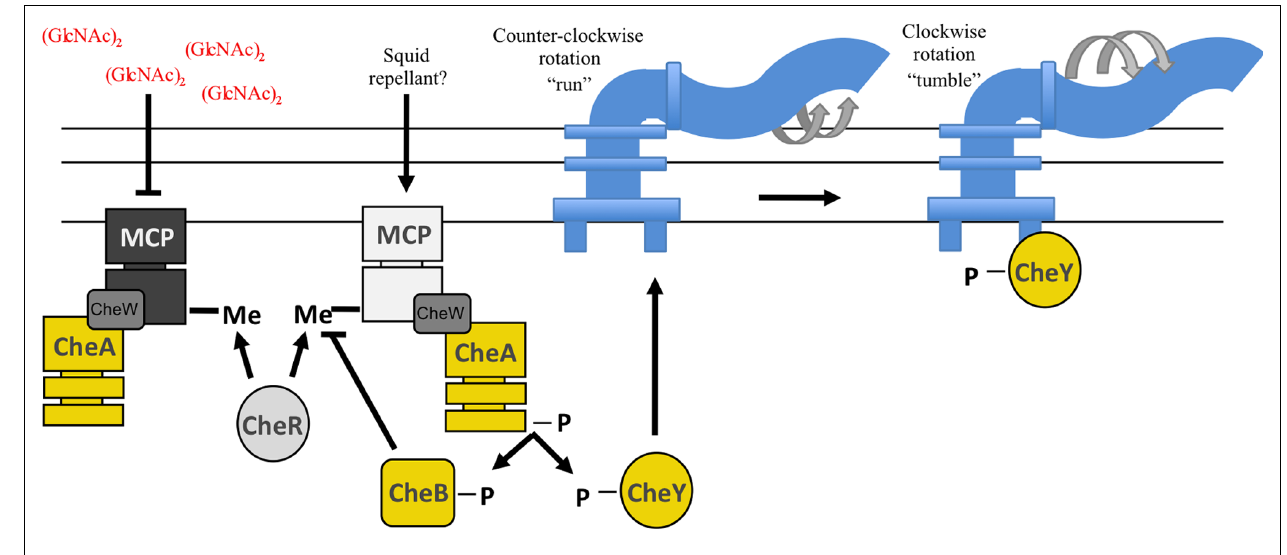
FIGURE 4 | Predicted chemotaxis pathway in V. fischeri . Methyl- accepting chemotaxis proteins (MCPs) recognize specific molecules found in the environment. A MCP is often physically linked to the sensor kinase, CheA, through the CheW protein. Ligand recognition by the MCP leads to a change in the activity of CheA. Binding of an attractant, such as (GlcNAc) 2 , inhibits CheA kinase activity resulting in a “run.” Conversely, interaction with a repellant promotes CheA autophosphorylation wherein the phosphoryl groups are donated to both CheB and CheY.